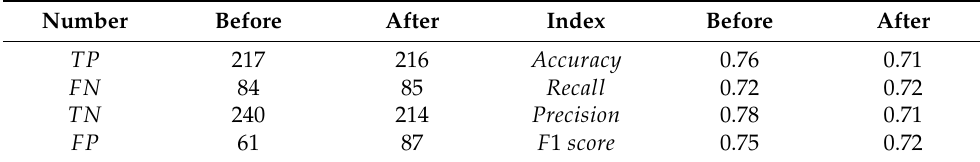
Figure 12. The susceptibility map of Bijie and model performance after excluding the clustering attribute. ( a ) The importance of factors in the RF model before exclusion. ( b ) ROC curves and AOC values of each model after exclusion. ( c ) The landslide susceptibility map after exclusion. ( d ) Comparison of models’ simulated effects before and after exclusion (the percentage of area in the very high level after exclusion was 0.35%, and the percentage of points in the very low level after exclusion was 2%). Table 4. Comparison of confusion matrices and accuracy indexes of the test set before and after exclusion (RF).